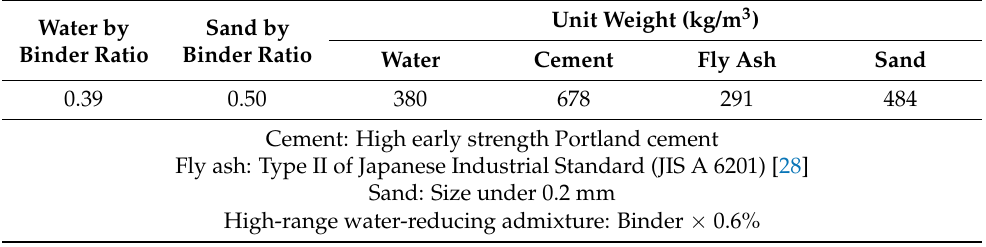
Table 1. Mixture proportion.